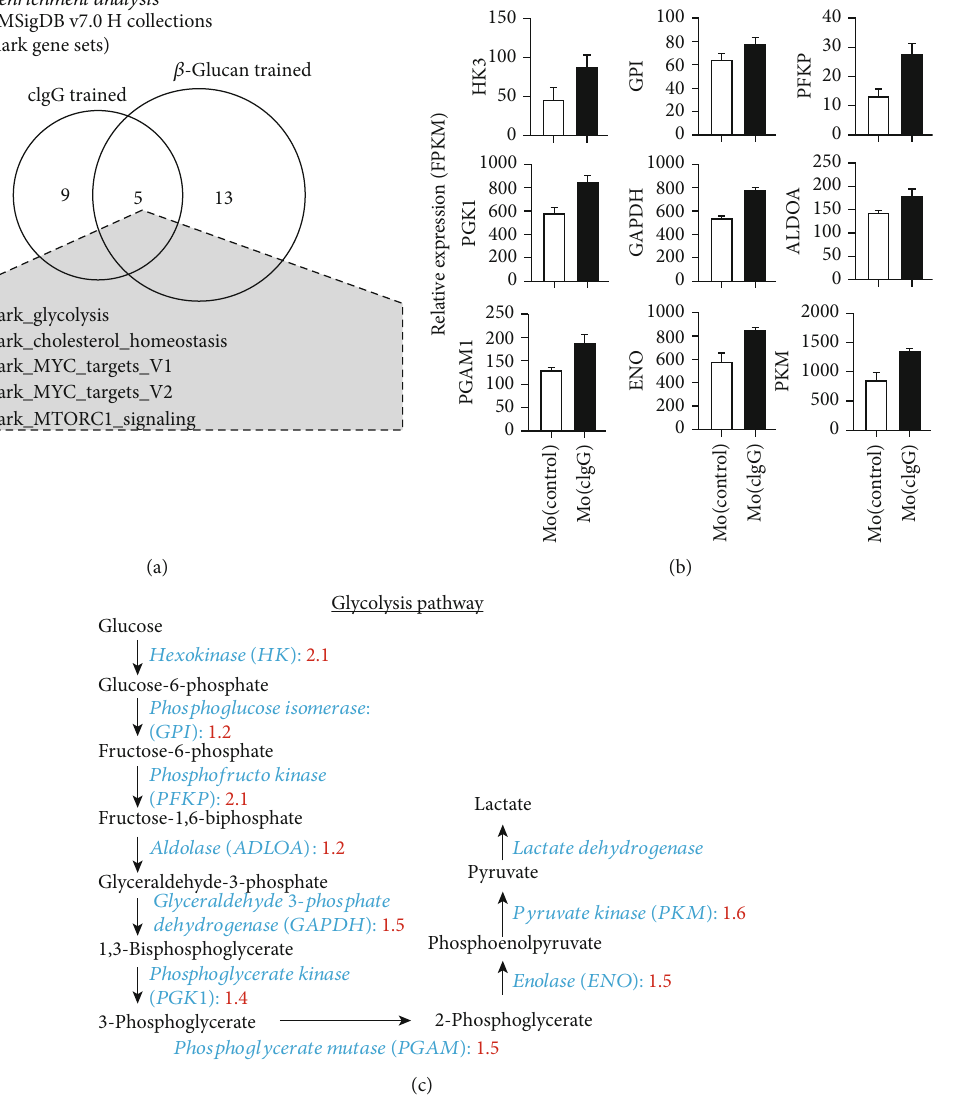
Figure 4: Comparative transcriptomic analysis between cIgG- and β -glucan-trained monocytes. (a) Venn diagram of GSEA of trained monocytes using hallmark gene sets collected in MSigDB v7.0. The fi ve shared hallmark gene sets were glycolysis, cholesterol homeostasis, MYC-targets_V1, MYC-targets_V2, and MTORC1_signaling. (b) Relative gene expression of glycolytic enzymes (HK3, fold change ð fc Þ = 2 : 1 , P = 0 : 00453 ; GPI, fc = 1 : 2 , P = 1 : 75 E − 11 ; PFKP, fc = 2 : 1 , P = 3 : 07 E − 09 ; PGK1, fc = 1 : 2 , P = 2 : 39 E − 09 ; GAPDH, fc = 1 : 5 , P = 0 ; ALDOA, fc = 1 : 4 , P = 2 : 16 E − 11 ; PGAM1, fc = 1 : 5 , P = 7 : 34 E − 09 ; ENO, fc = 1 : 5 , P = 0 : 00442 ; and PKM, fc = 1 : 6 , P = 2 : 86 E − 10 ) was de fi ned by FPKM (fragments per kilobase of exon model per million reads mapped) values from RNA sequencing (GSE102728) as compared between the Mo(cIgG) and Mo(control). Data ( mean ± SEM ) are from three independent experiments. P values indicate the posterior probability of di ff erential expression (PPDE). (c) Glycolysis pathway from glucose to lactate. Fold changes in glycolytic enzymes were compared between cIgG-trained and control cells, as labeled in ( P = 0 : 0255 , Figure 7(a)) or moderate EULAR response ( P = 0 : 0411 , Figure 7(a)) compared to that of poor responders. A similar correlation was observed between the myeloid signatures with clinical therapeutic response (Figure 7(b)). However, both the lymphoid and fi broid scores, despite also marking the in fl ammatory process, were not associated with clinical outcomes (Figures 7(c) and 7(d)). The data indicate that cIgG-trained signatures can be used for predicting clinical therapeutic responders to anti- TNF α therapy.